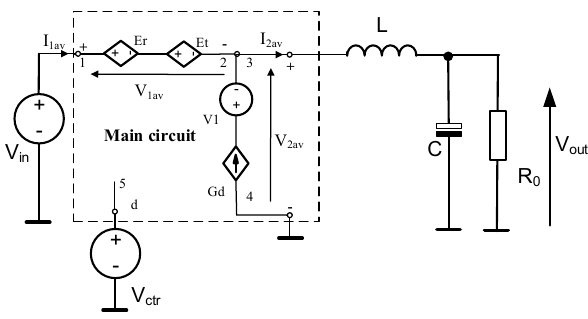
Figure 3. Simulation diagram of the buck converter.